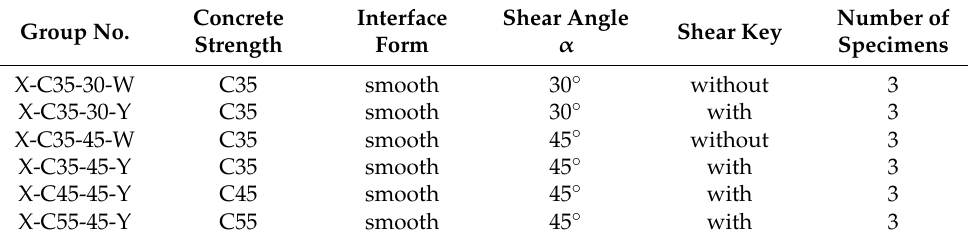
Note: X denotes slant shear specimens, W denotes without shear key, and Y denotes with shear